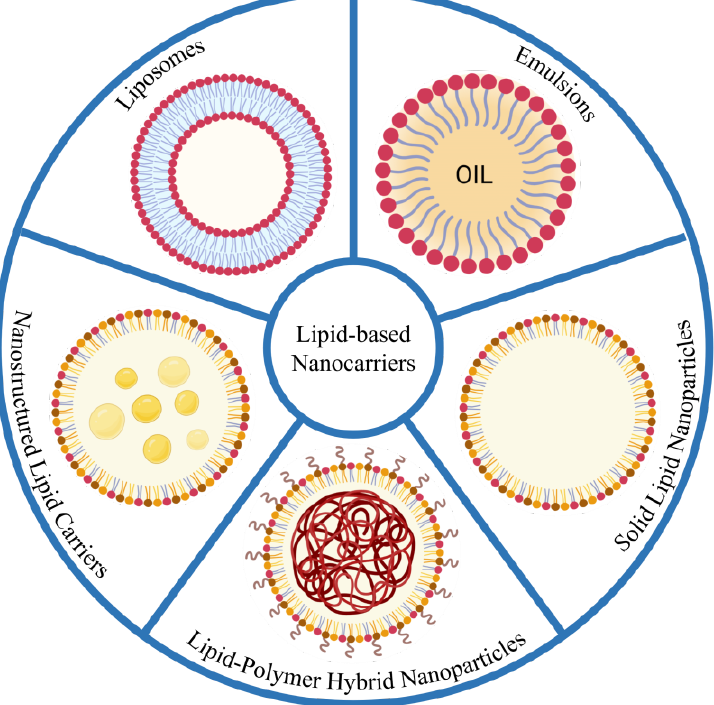
Figure 3. The different lipid based nanocarriers used in pulmonary delivery of chemotherapeutics. Liposomes